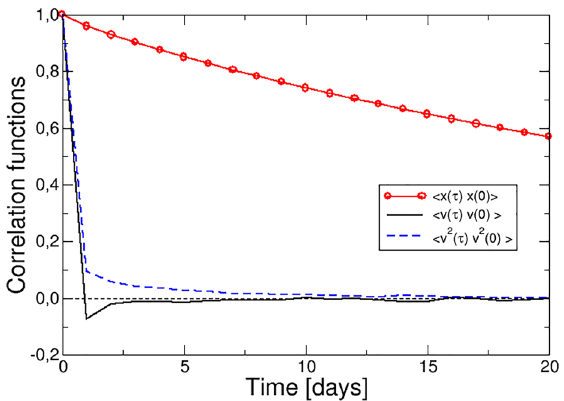
Figure 3. Autocorrelation functions of the log-price (red line and circles), log-return (continuous black line) and volatility (broken blue